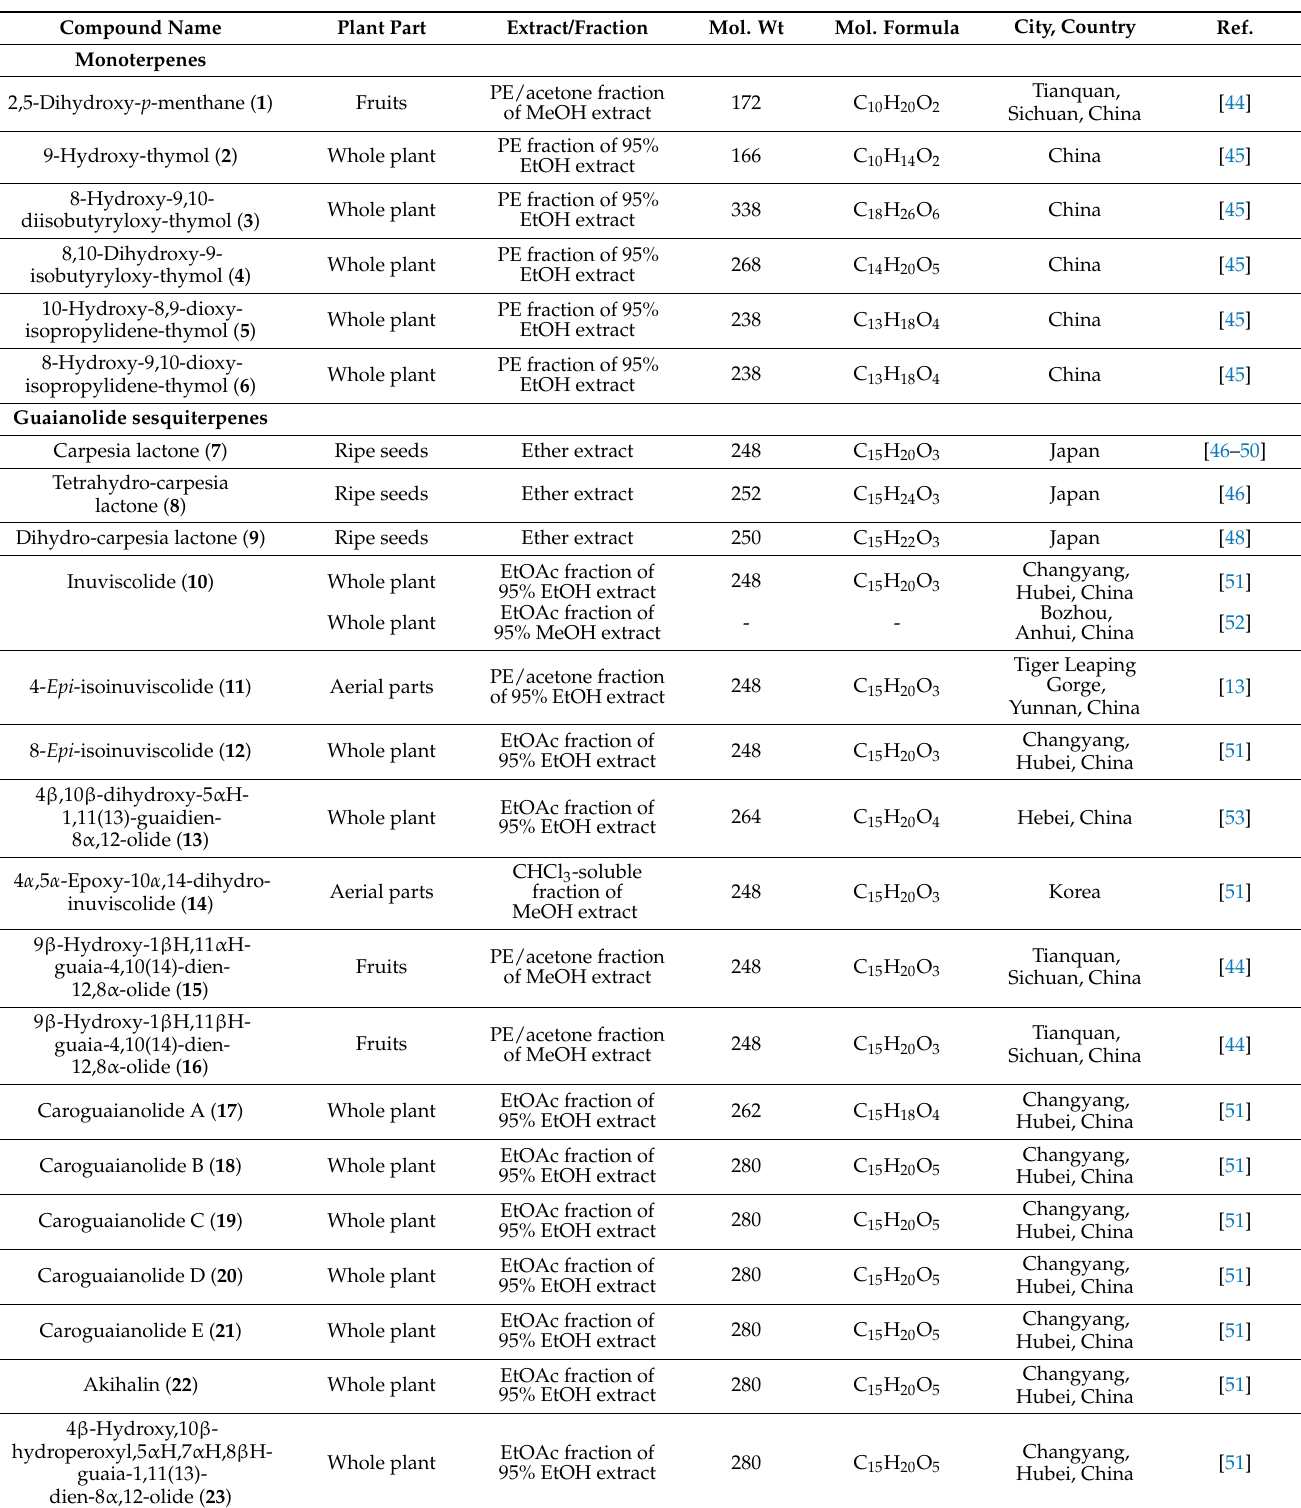
Table 1. List of reported metabolites from Carpesium abrotanoides